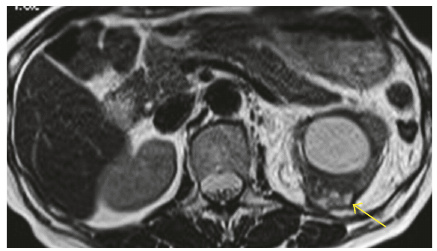
Figure 2: MRI: the tumor contained small cysts (arrow).